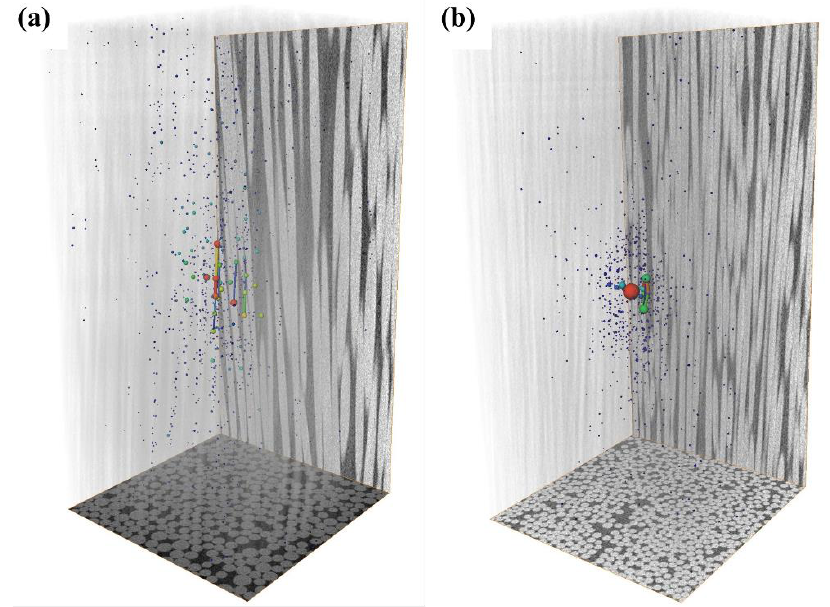
Figure 14. Three-dimensional pores of basalt fiber core rod ( a ) and glass fiber core rod ( b ).